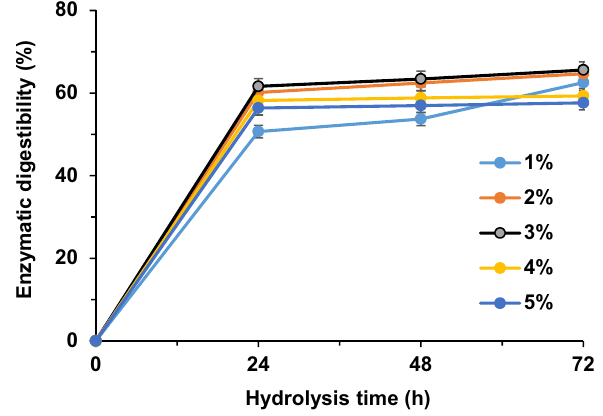
Figure 2. Enzymatic digestibility of pretreated PKC using different oxalic acid concentration.